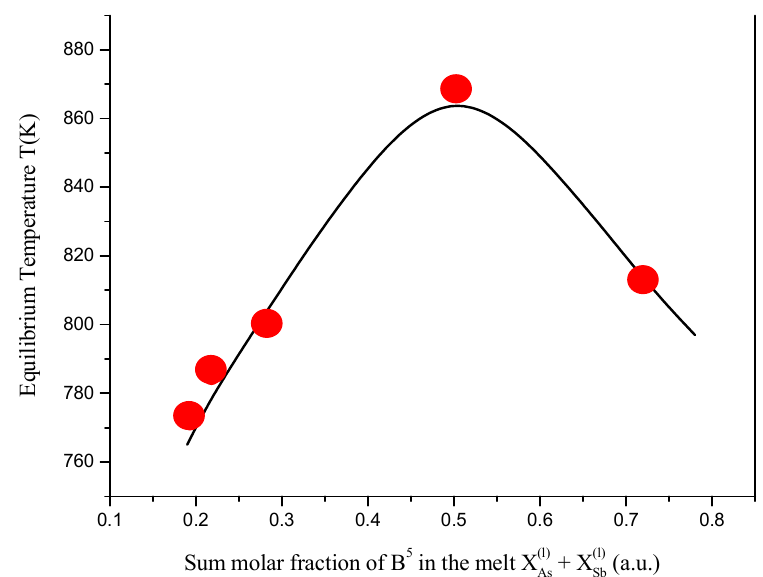
Figure 2. Equilibrium temperature T(K), depending on the sum molar fraction of B 5 components in the equilibrium to solid solution melt: X for solid solutions with constant composition In 0.11 Ga 0.39 As 0.08 Sb 0.42 . Points are experimental data, line is calculated by EFLCP model [13,14].